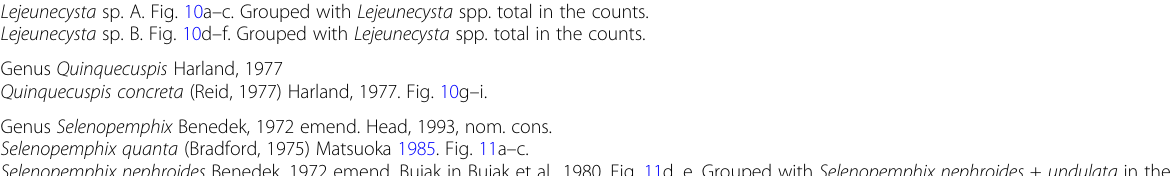
Table 1 Dinoflagellate cyst and acritarch taxa recorded in the present study, and their classification and authorial attributions. All taxa are considered in situ with the exception of the genus Cleistosphaeridium which is presumed reworked (Continued) Lejeunecysta sp. A. Fig. 10a – c. Grouped with Lejeunecysta spp. total in the counts. Lejeunecysta sp. B. Fig. 10d – f. Grouped with Lejeunecysta spp. total in the counts. Genus Quinquecuspis Harland, 1977 Quinquecuspis concreta (Reid, 1977) Harland, 1977. Fig. 10g –